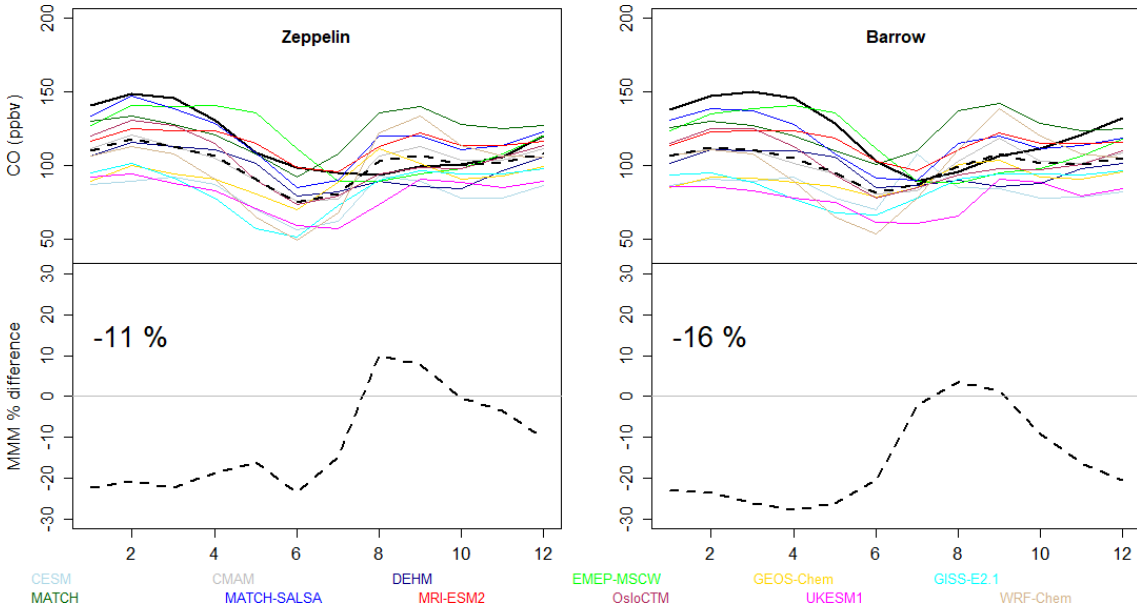
Figure 7. Arctic surface CO by month; seasonal cycle model comparisons. The solid black line represents the observed CO monthly means, and the dashed black line is the multi-model median (MMM). Bottom panels show the MMM percent difference [(MMM − measurements)/measurements × 100]. Note that model results are from the 2014–2015 mean. When available, the same years are used for the observations. However, for Zeppelin observations are the mean of